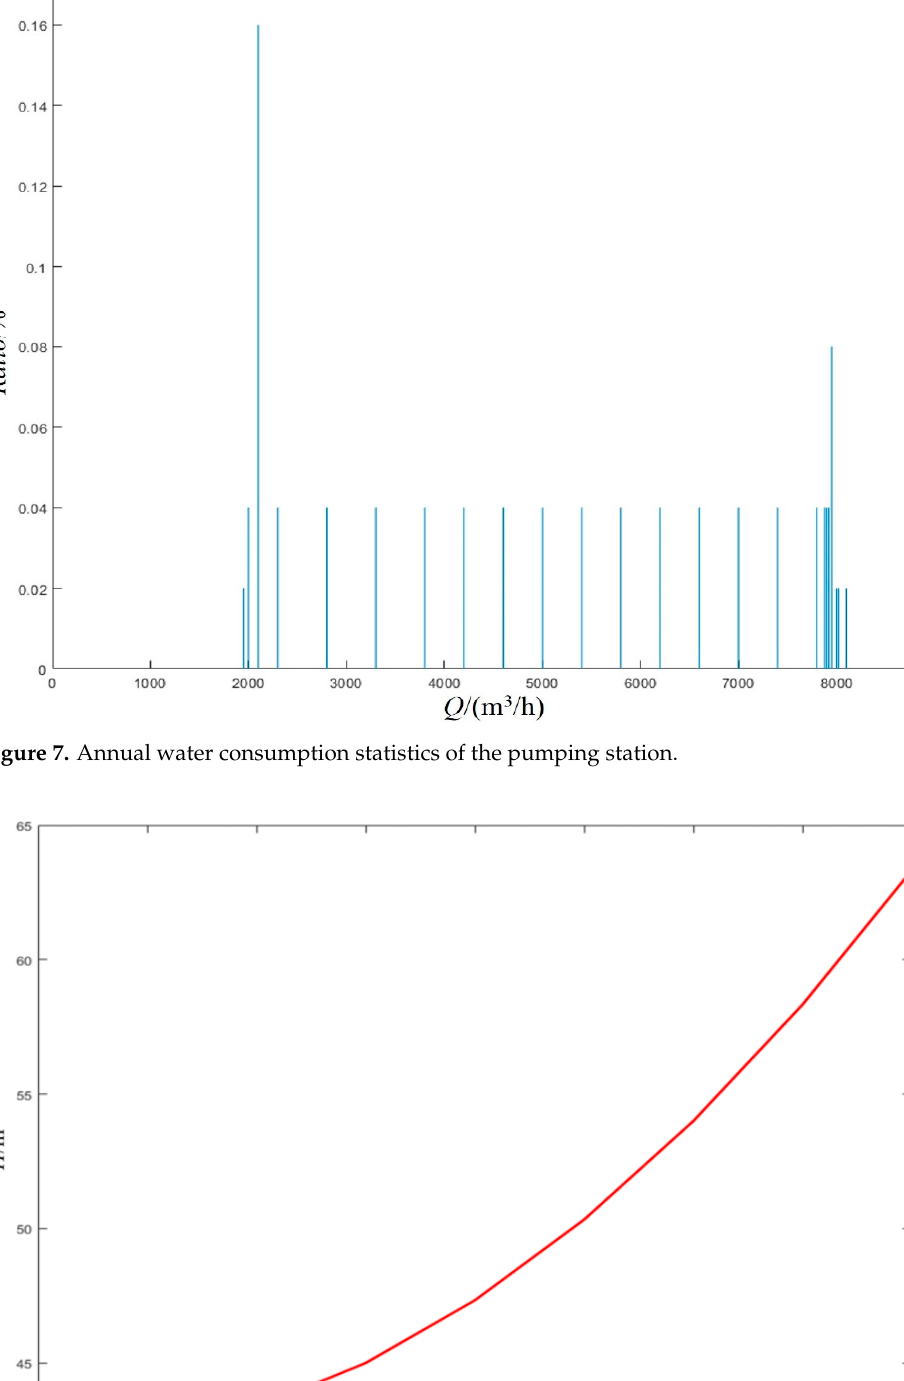
Figure 9. Shaft power of the original configuration and of the PVFPS.